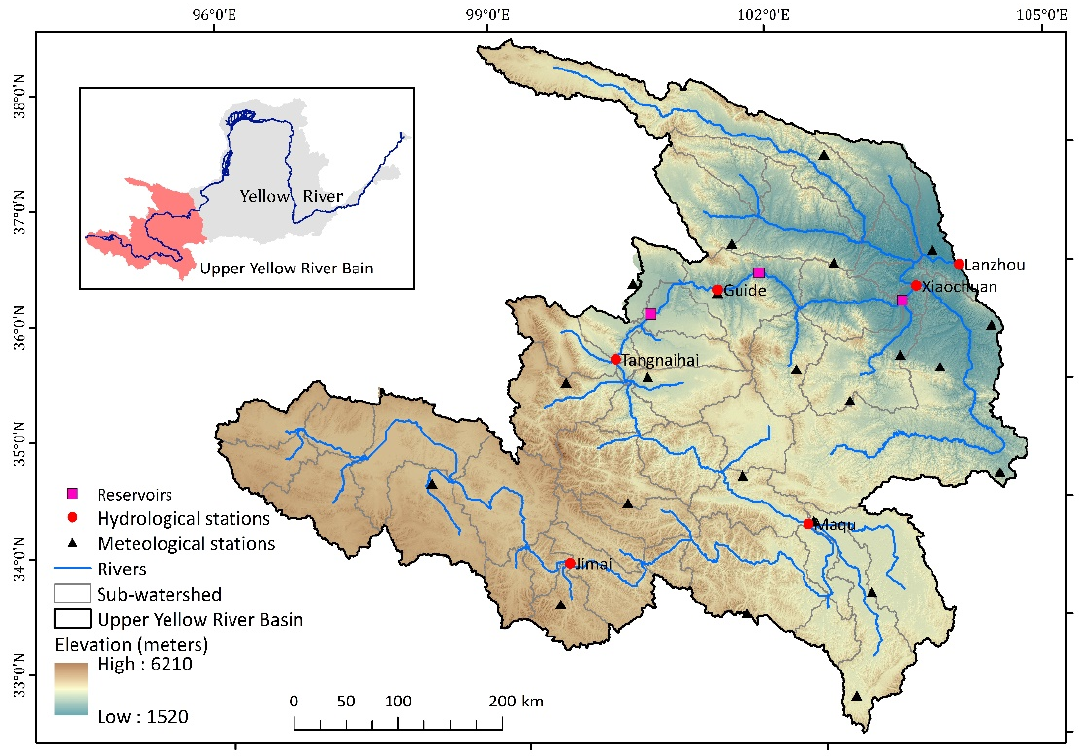
Figure 1. The upper Yellow River Basin.